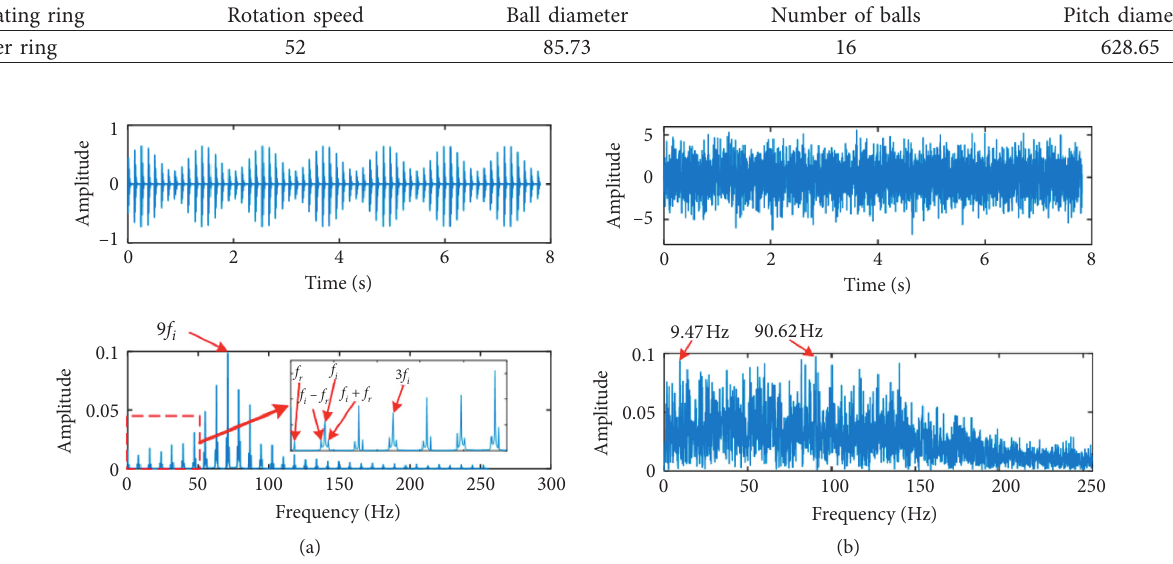
Figure 3: The inner ring fault simulation signal: (a) no noise added; (b) noise added.